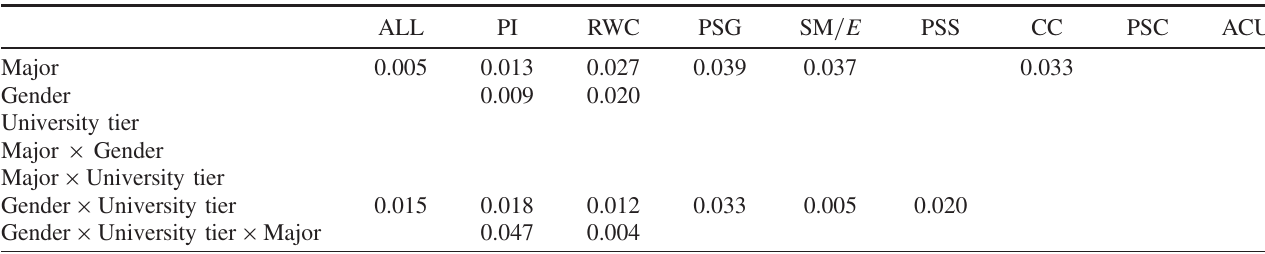
TABLE IV. The results of a three-way ANOVA for each category of epistemological beliefs towards physics learning. The table lists the p values of the ANOVA results for all of the eight categories, which are less than 0.05, indicating the significant main effects of the independent variables or the significant interaction effects between independent variables at significance level ¼ 0 . 05 . See category definitions in text and Fig. 2